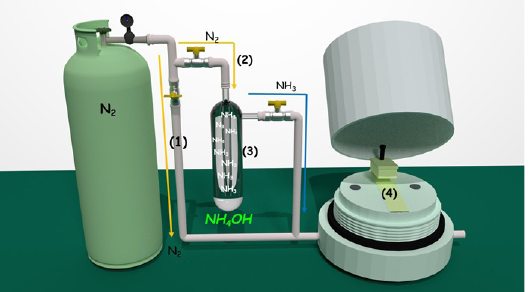
cylinder, line Figure 2. Gas detection system composed of an N 2 (1) that takes nitrogen gas to the sample holder (4) that contains the IDE’s. In (4) the release of NH occurs, by bubbling N (2) in 3 2 a solution of NH OH in 4